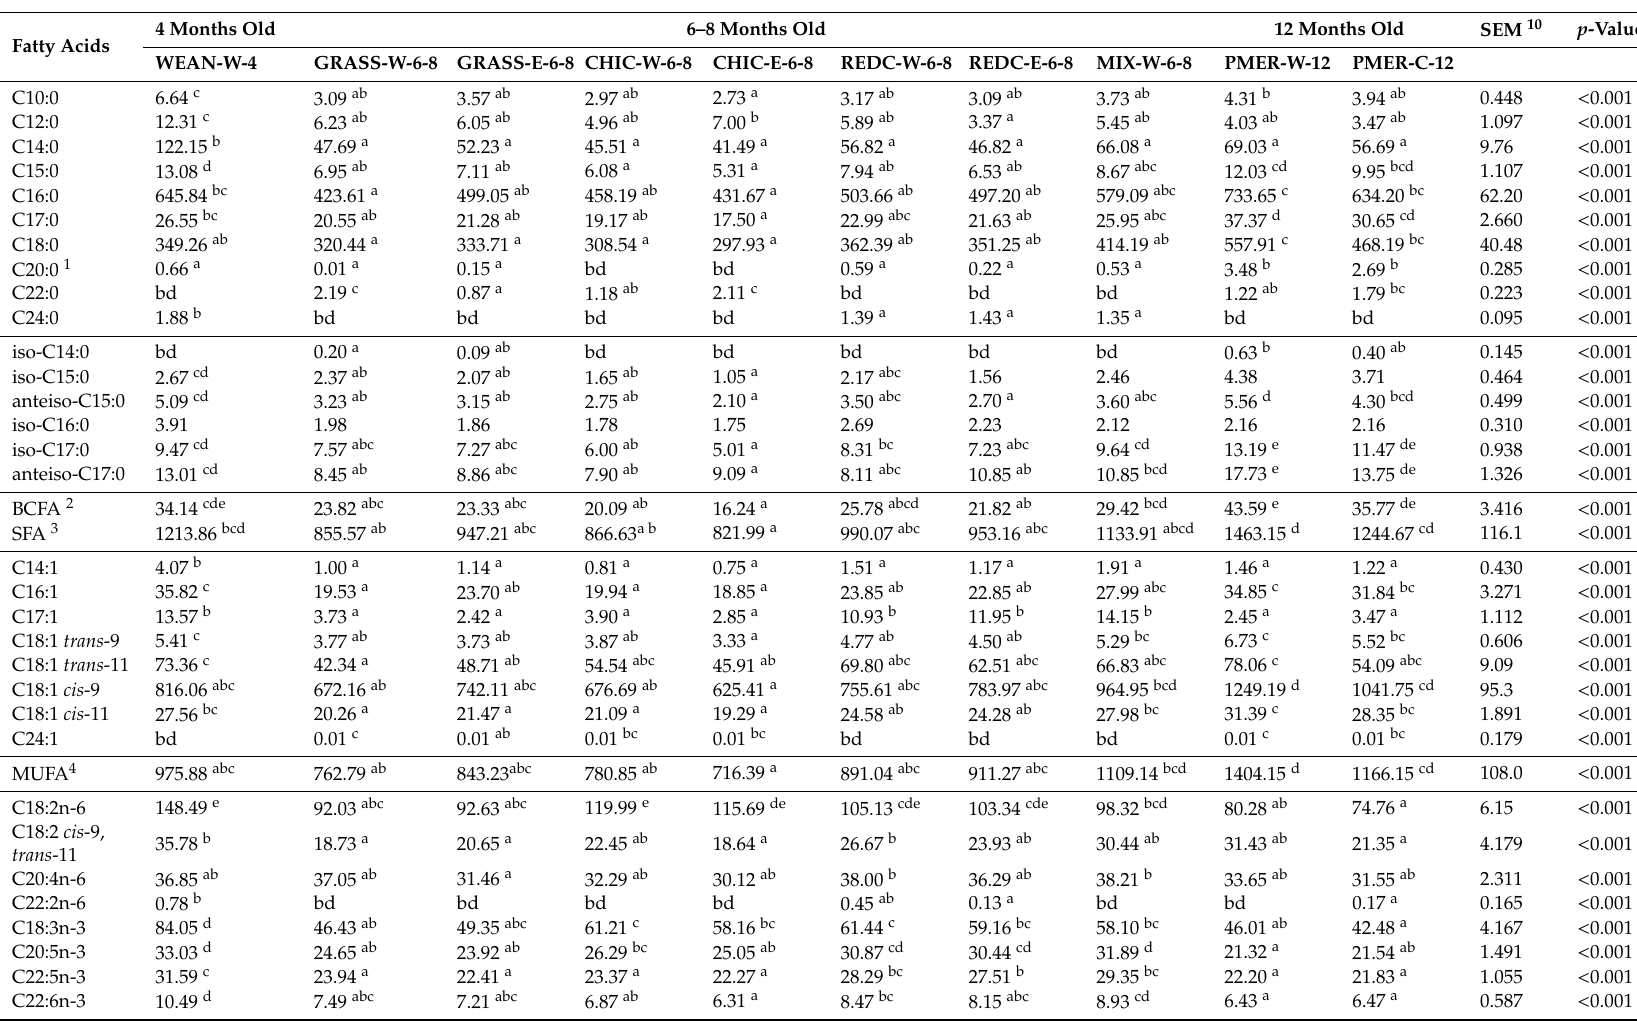
Table 2. Fatty acid content (mg / 100 g raw meat) of Longissimus thoracis from lambs reared under di ff erent New Zealand commercial forage production systems. Fatty